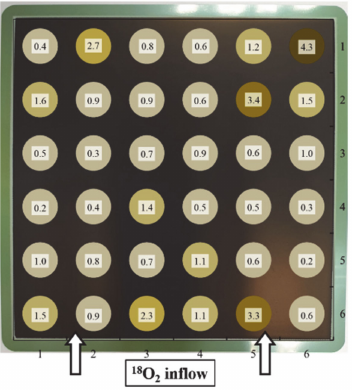
Figure 12. Chromium distribution in the PSC oxygen electrode of Ni-YSZ|YSZ|GDC|PSC SOEC short stack. The values represent the ratio of Cr counts to the total positive ion counts. The white arrows denote the direction of air flow at the PSC oxygen electrode side.